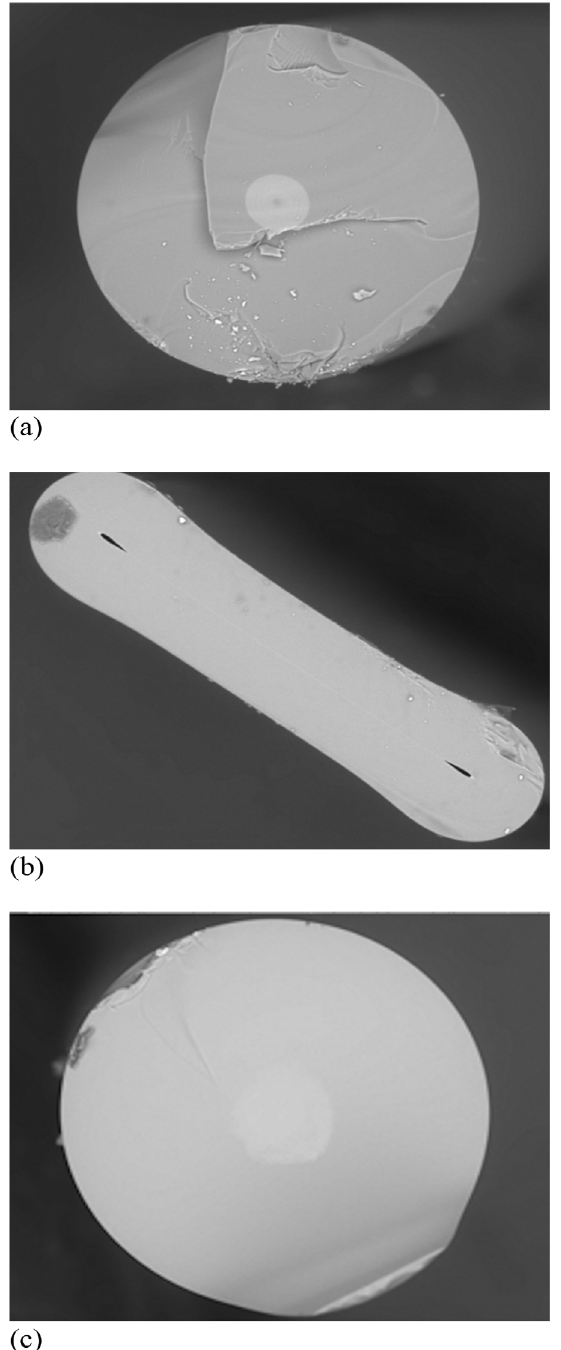
Fig 1. Photomicrograph view. Fig show the cross-sectional Photomicrograph of: (a) 270 μ m Ge-doped cylindrical fibre with a core size of 42 μ m, (b) 750 μ m Ge-doped flat fibre, and (c) PCF-collapsed (see Table 1 for full